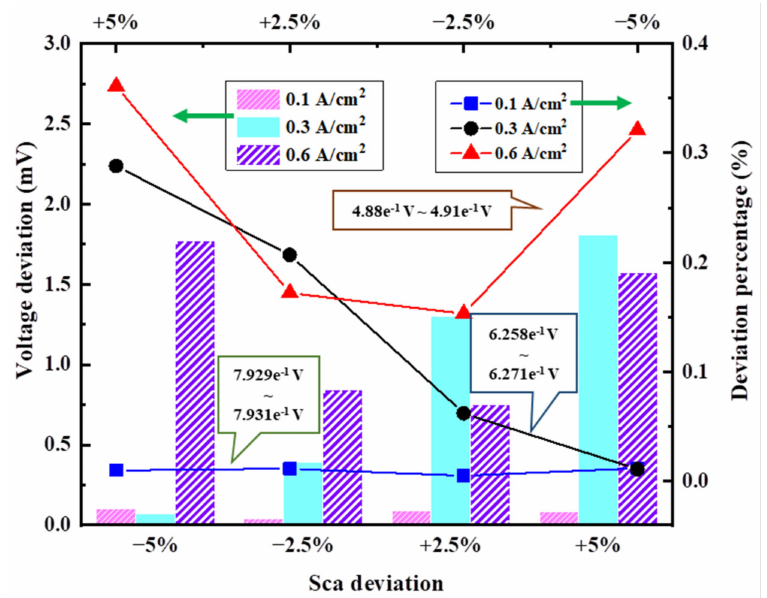
Figure 8. Impacts of CMFR deviations on the voltage deviations and their corresponding percentages under three current densities.